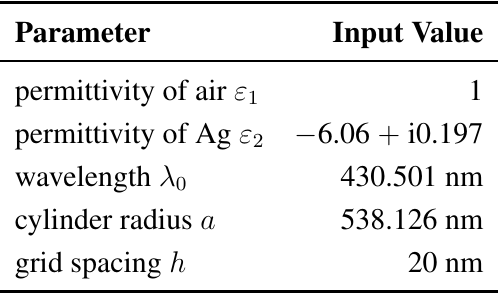
Table 1. Simulation parameters for an infinitely-long Ag cylinder.